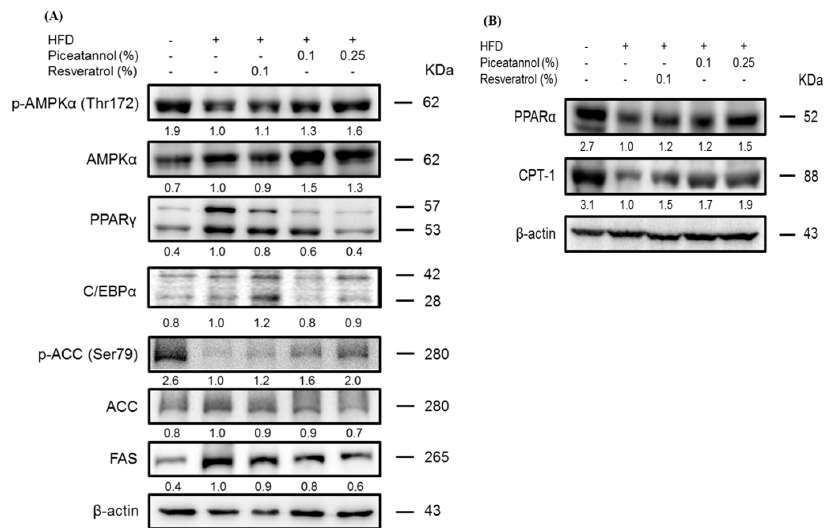
Figure 4. Effect of piceatannol supplementation on ( A ) adipogenic proteins and ( B ) beta-oxidation- related proteins in HFD-fed C57BL/6 mice. Perigonadal protein levels were evaluated by western blot analysis. The values under each lane indicate relative density of the band normalized to β -actin. The western blot is representative of at least three independent experiments.